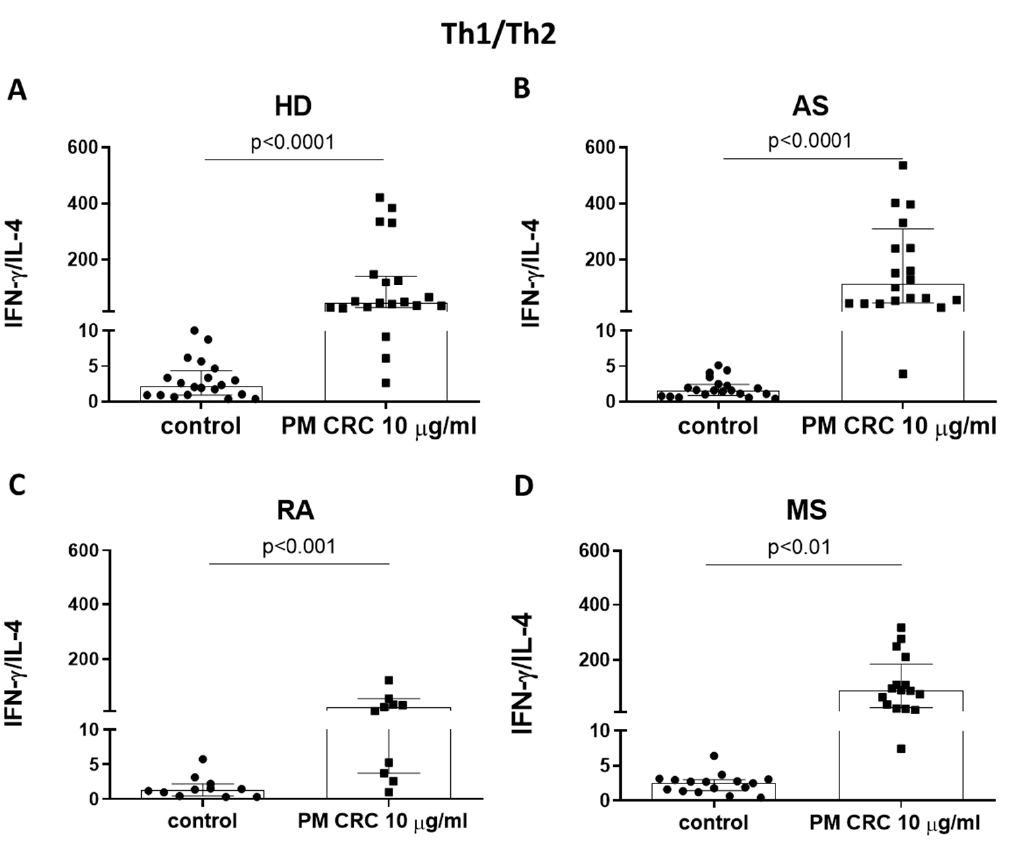
Figure 1. Effect of the exposure of PBMCs to PM CRC on the ratio of Th1/Th2 cells in patients and HD. After PBMCs stimulation, the proportion of CD4 + cells positive for IFN- γ (Th1) and IL-4 (Th2), and the corresponding Th1/Th2 ratio were determined in HD ( A ) and patients with AS ( B ), RA ( C ), and MS ( D ). Data are presented as median ± interquartile range from 20 independent experiments for HD ( A ) and AS ( B ), 11 for RA ( C ), and 16 for MS ( D ). Statistically significant difference was estimated at p < 0.05.